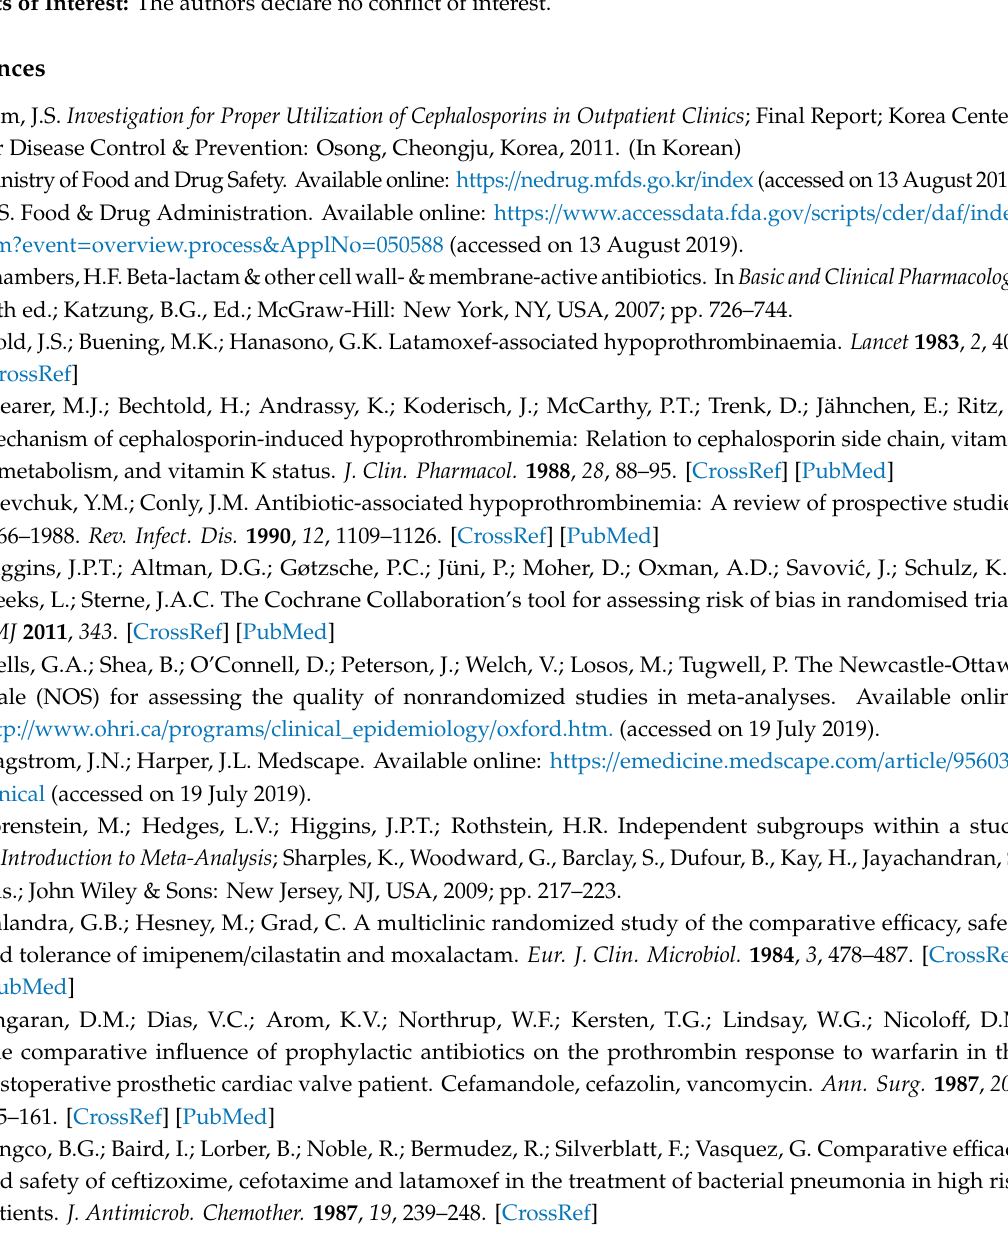
Table S1: Search strategy, Table S2: National Evidence-based healthcare Collaborating Agency (NECA) RoB guidelines, Table S3: Criteria for modified Newcastle–Ottawa Scale, Table S4: Newcastle–Ottawa Scale (NOS) for assessing the quality of cohort studies, Table S5: Newcastle–Ottawa Scale (NOS) for assessing the quality of case-control, case-population and case / noncase studies. Figure S6: Subgroup analyses of PT prolongation and